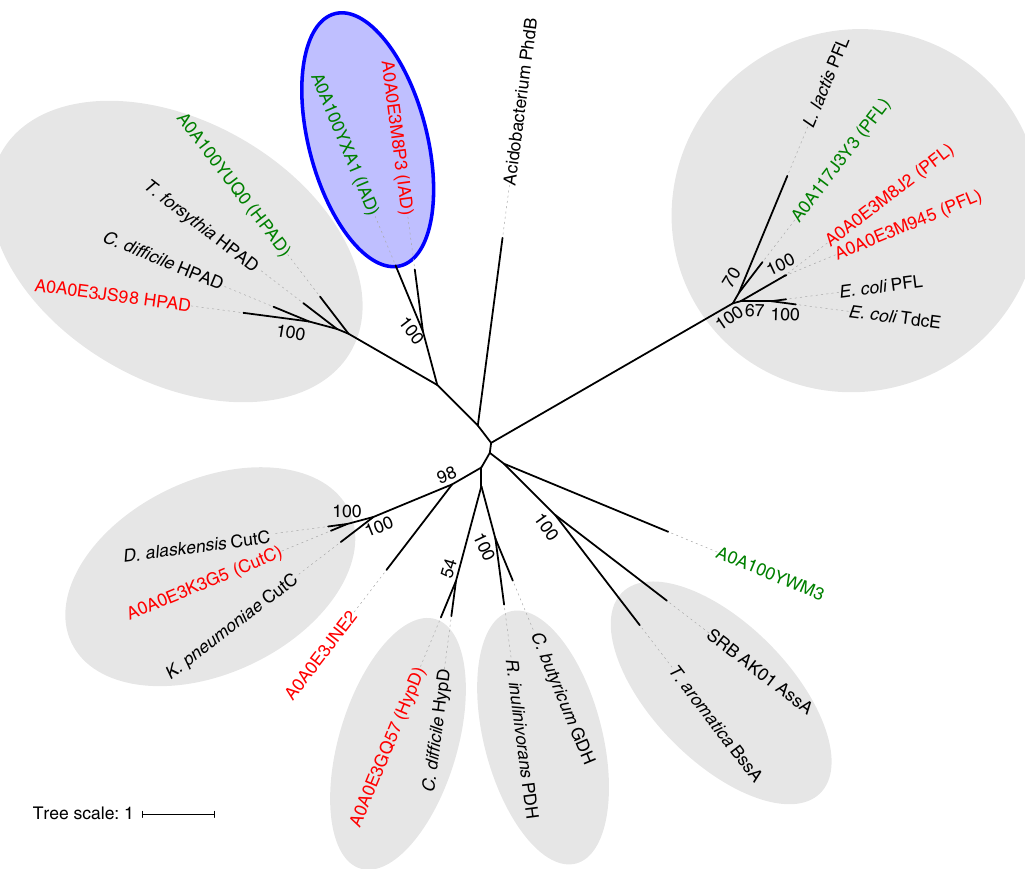
Fig. 2 Maximum likelihood phylogenetic tree of GREs. Included are Cs GREs (red), Os GREs (green), and biochemically validated GREs in other organisms (black). Of the Cs and Os GREs, only CsHPAD has been previously biochemically validated. Proposed functions of the other Cs and Os GREs are given in brackets. Candidate IADs are enclosed in the blue ellipse, of which OsIAD was validated in this study. PFL pyruvate formate lyase, TdcE 2-keto acid formate lyase, CutC choline-trimethylamine lyase, PDH propanediol dehydratase, GDH glycerol dehydratase, HypD trans -4-hydroxy- L -proline dehydratase, BssA benzylsuccinate synthase, AssA alkylsuccinate synthase, PhdB phenylacetate decarboxylase, HPAD p -hydroxyphenylacetate decarboxylase, and IAD indoleacetate decarboxylase reported in this study. Bootstrap con fi dence values >50 are indicated on the